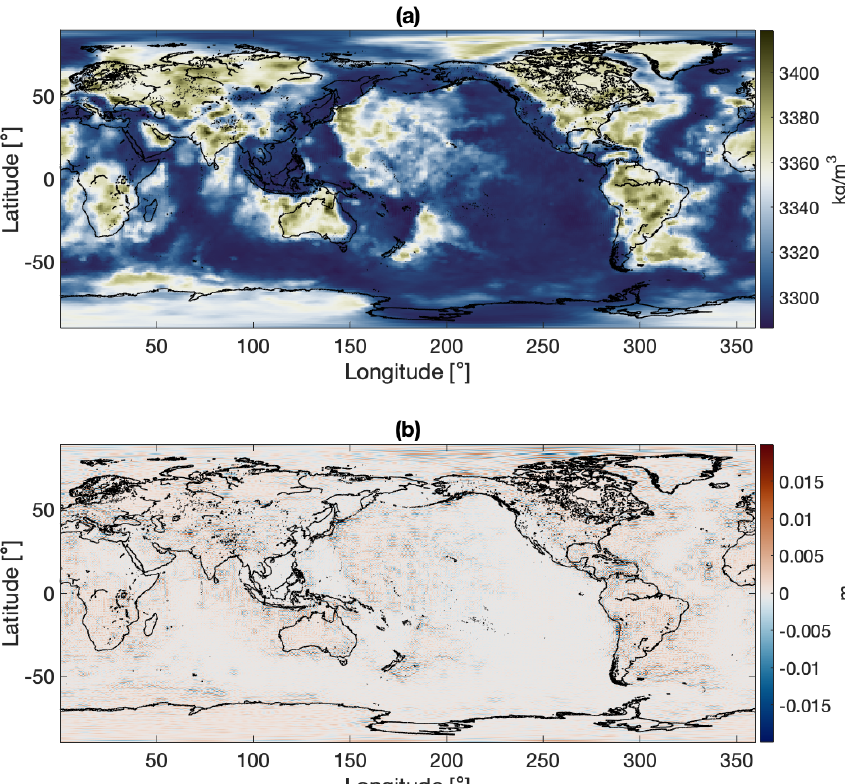
Figure 5. (a) WINTERC-G density variations in the mantle at a depth of 110km from the WINTERC-G model to ensure only typical mantle density anomalies. These were used in the spectral shell comparison as radially constant density variations between 56 and 80km depths. (b) Geoid differences of the laterally varying density from Fig. 5a between the WINTERC-G-based code and the GSH